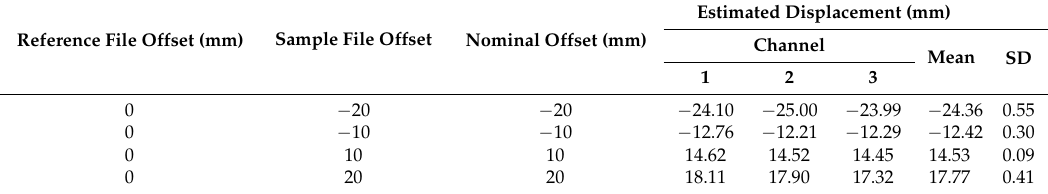
Table 4. Displacement estimates for outdoor test using an Orion Apex 102 mm Maksutov-Cassegrain Telescope.